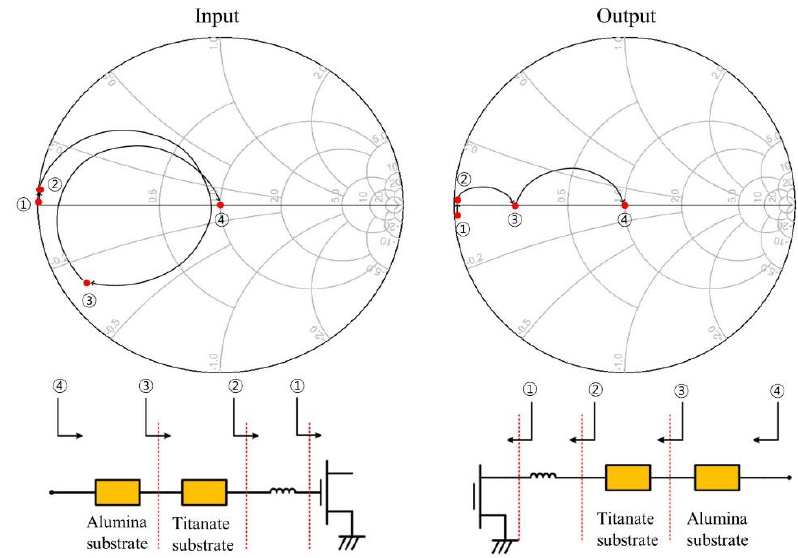
Figure 5. Impedance traces at the representative positions of input and output matching circuits.